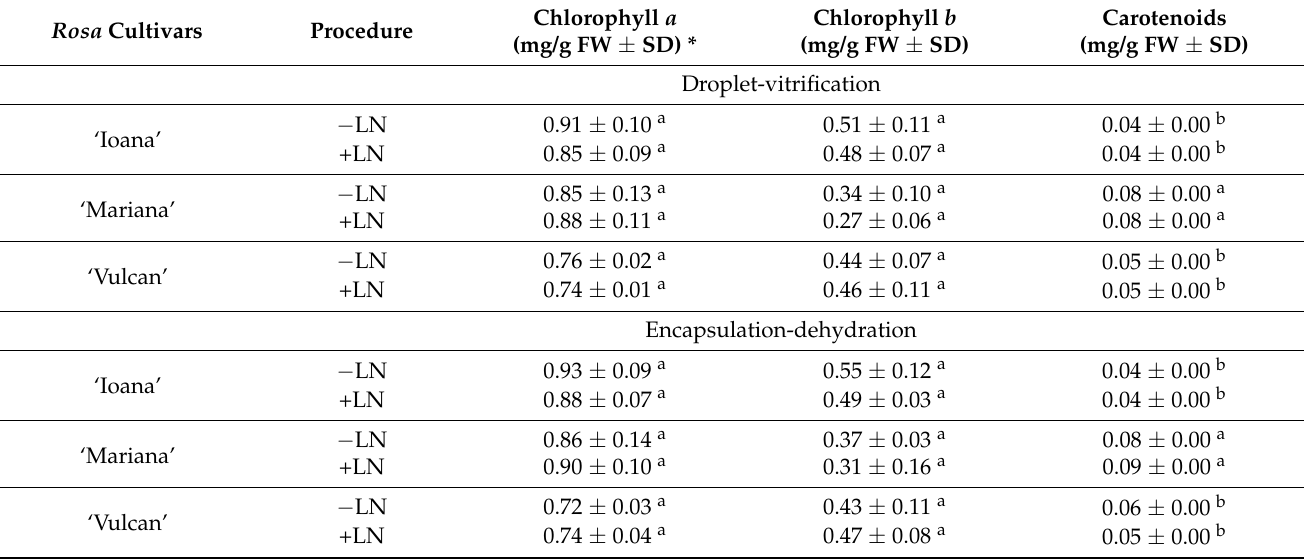
Table 4. Chlorophyll and carotenoid content in leaves derived from non-cryopreserved ( − LN)